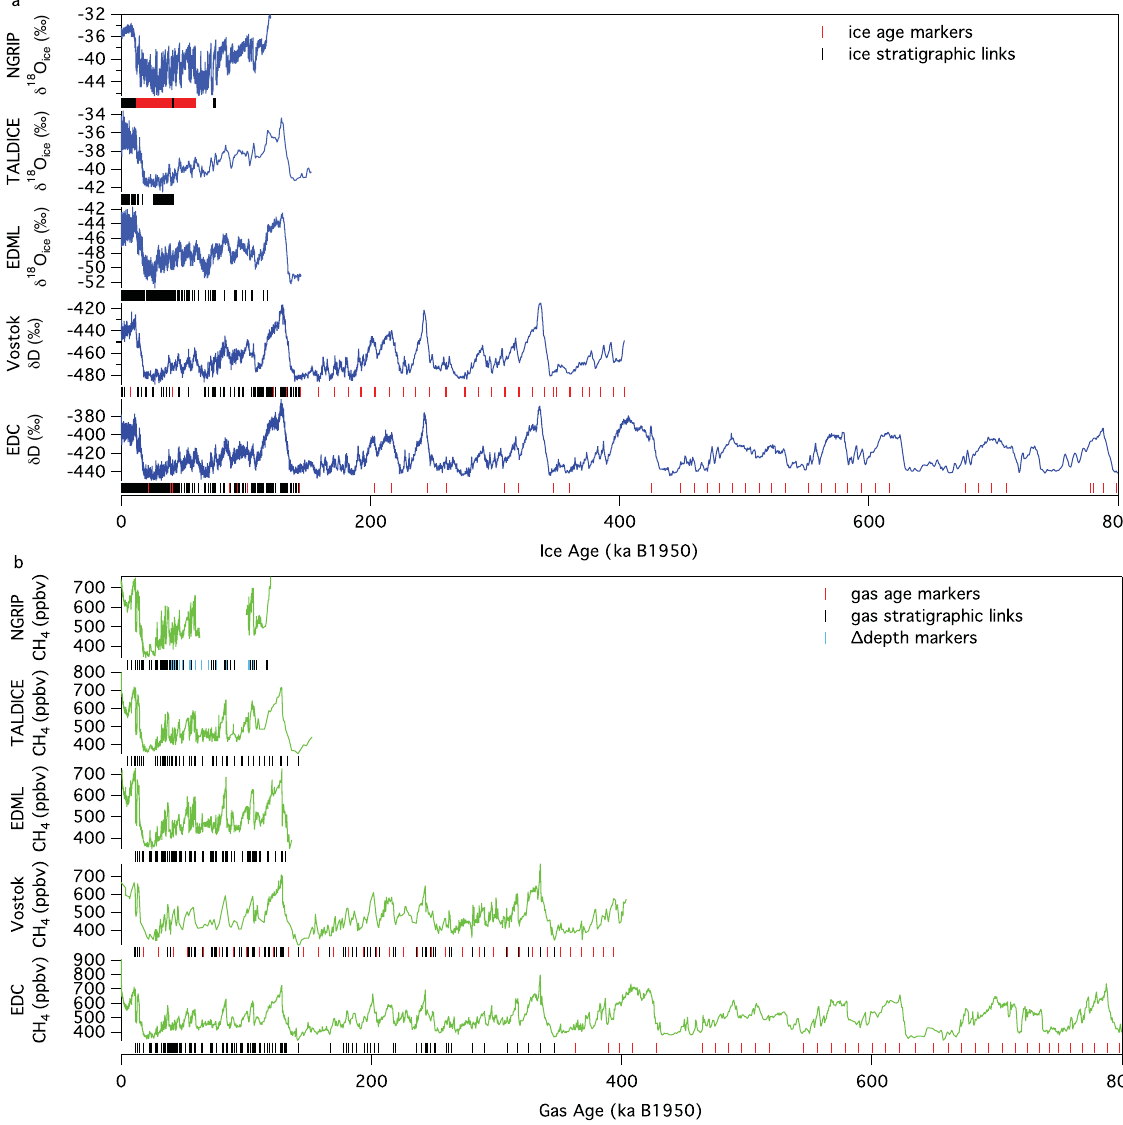
Fig. 5. (a) Water stable isotope records of NGRIP (NorthGRIP Community Members, 2004), TALDICE (Stenni et al., 2011), EDML (EPICA Community Members, 2006, 2010), Vostok (Petit et al., 1999) and EDC (Jouzel et al., 2007) on the AICC2012 age scale. (b) Methane records of NGRIP (Greenland composite: Capron et al., 2010; EPICA Community Members, 2006; Fl¨uckiger et al., 2004; Huber et al., 2006; Schilt et al., 2010), TALDICE (Buiron et al., 2011; Sch¨upbach et al., 2011), EDML (EPICA Community Members, 2006), Vostok (Caillon et al., 2003; Delmotte et al., 2004; Petit et al., 1999) and EDC (Loulergue et al., 2008) on the AICC2012 age scale. Stratigraphic links and age marker positions are displayed under each